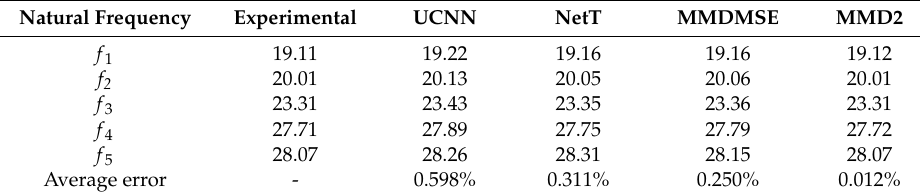
Figure 10. Average error of natural frequency. Table 3. Model updating result with 4000 samples.